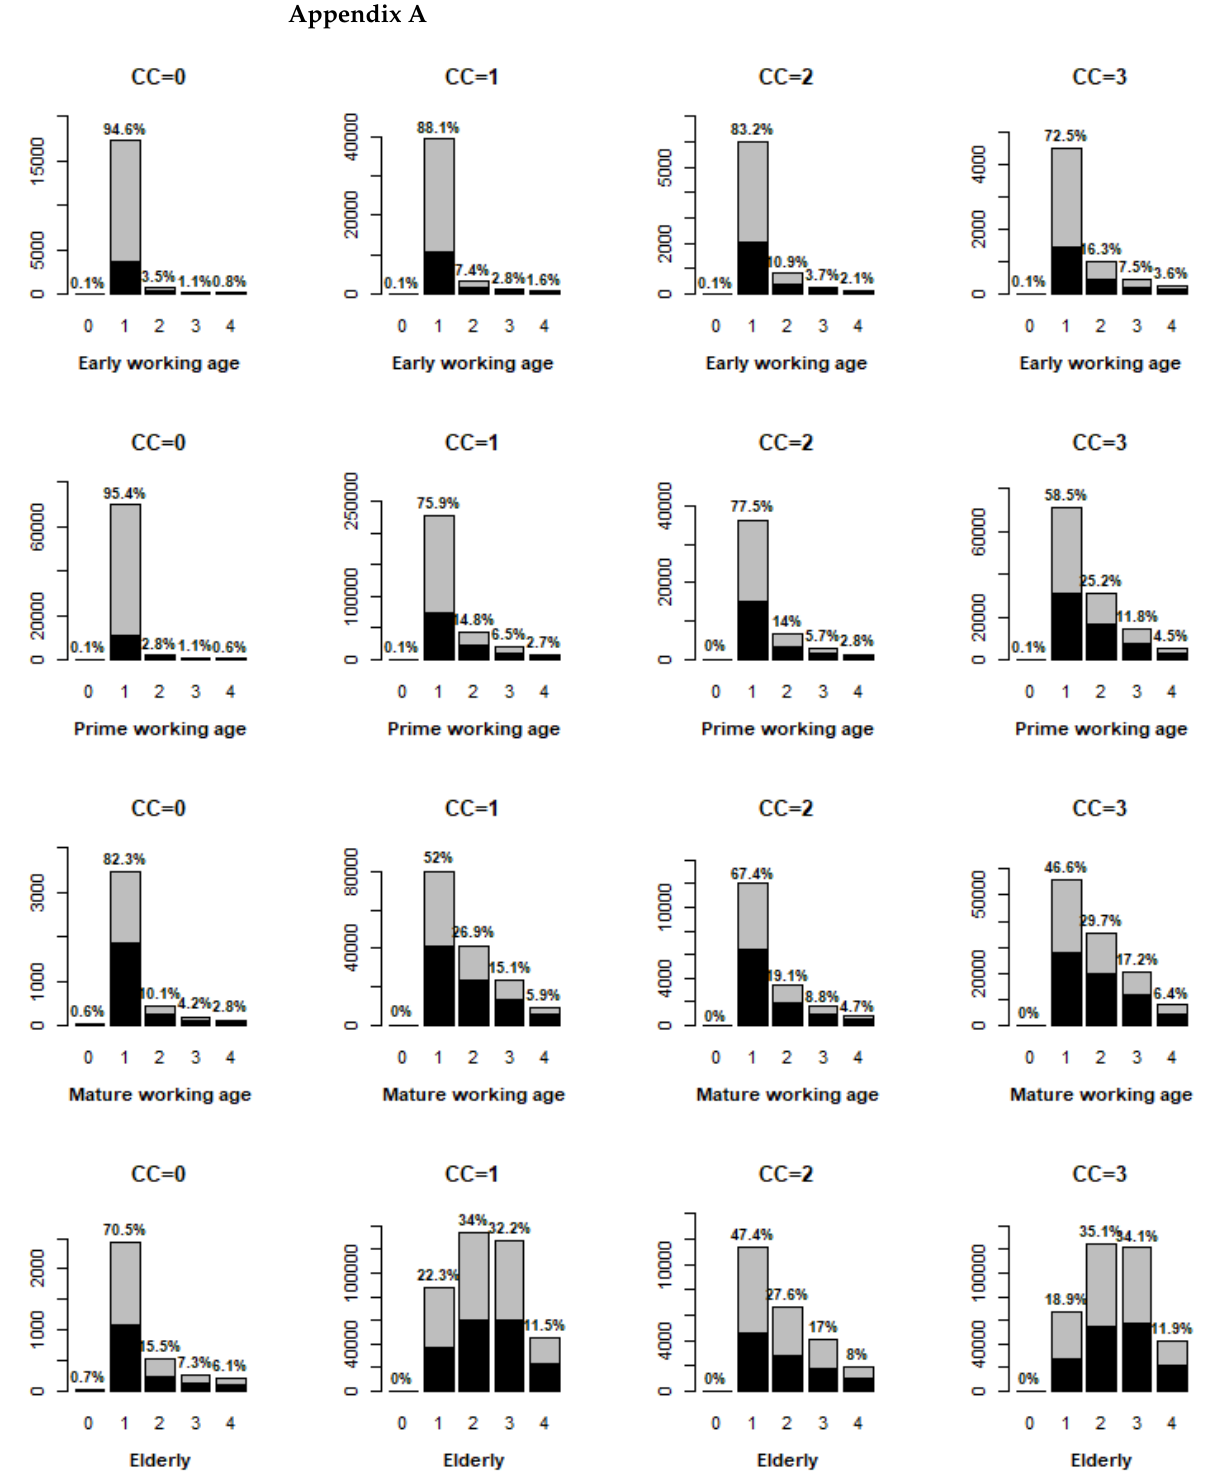
Figure A1. ROM and differences in patients’ characteristics among demographic factors and CC. The black is for male and grey is for female.